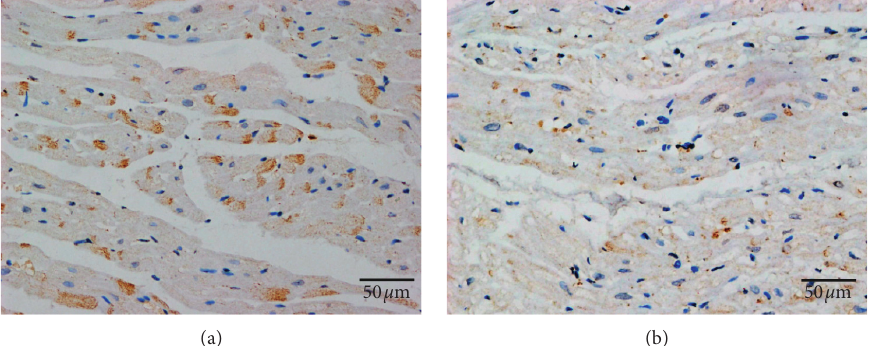
Figure 4: TH staining of the left atrium in both control group (a) and experimental group (b). (a) The left atrium of the control group seen at high magnification. (b) The left atrium of the experimental group seen at high magnification. TH staining showed that the TH-positive component (red arrows) was significantly decreased in the left atrium of the experimental group compared with that of the control